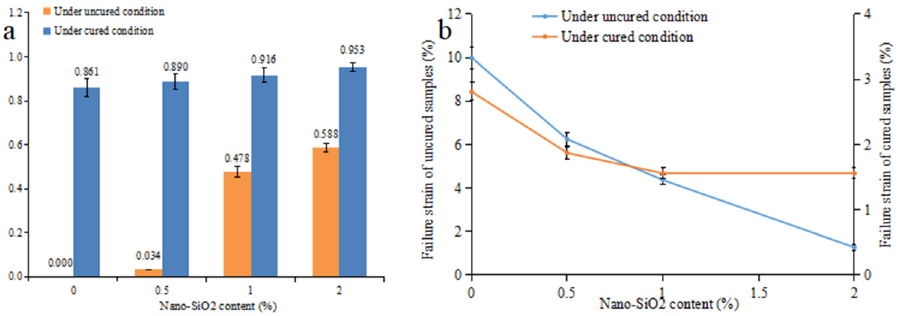
Figure 11. The ( a ) brittleness index and ( b ) displacement in peak shearing strength of the nano-SiO 2 - reinforced clayey soil (Values are means ±